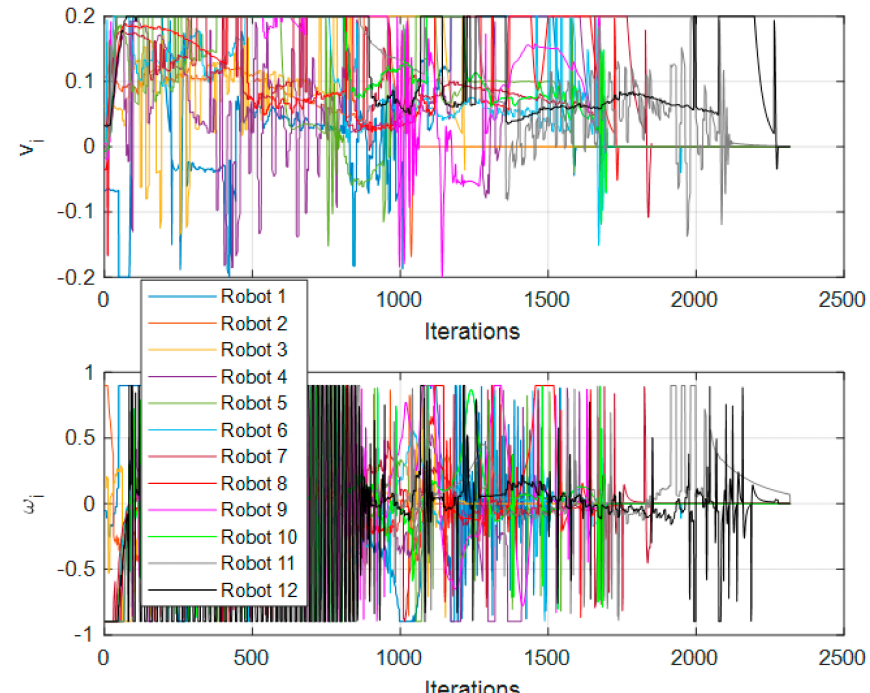
Figure 15. Input values for velocities in the 12-robot